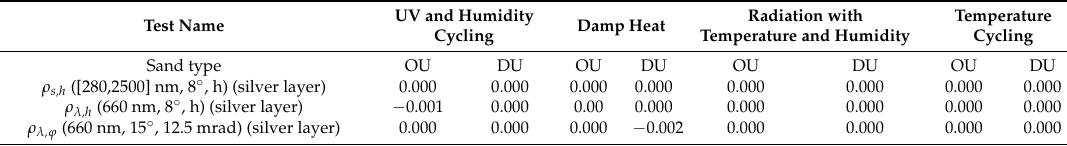
Table 5. Results of reflectance differences from the third set of samples, after the copper-accelerated acetic acid salt spray (CASS) test. OU: Ouarzazate; DU: